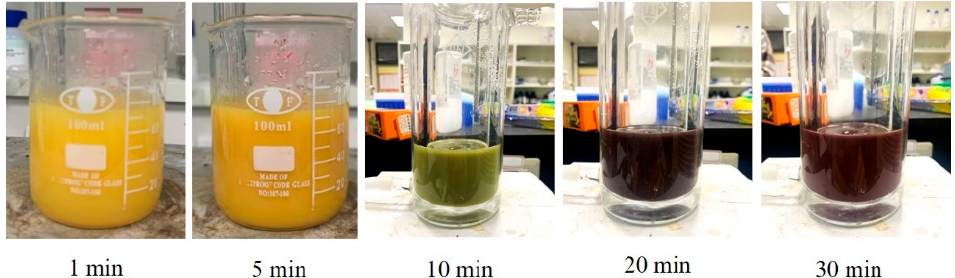
Figure 9. Color changes according to reaction times when synthesizing CuNPs.